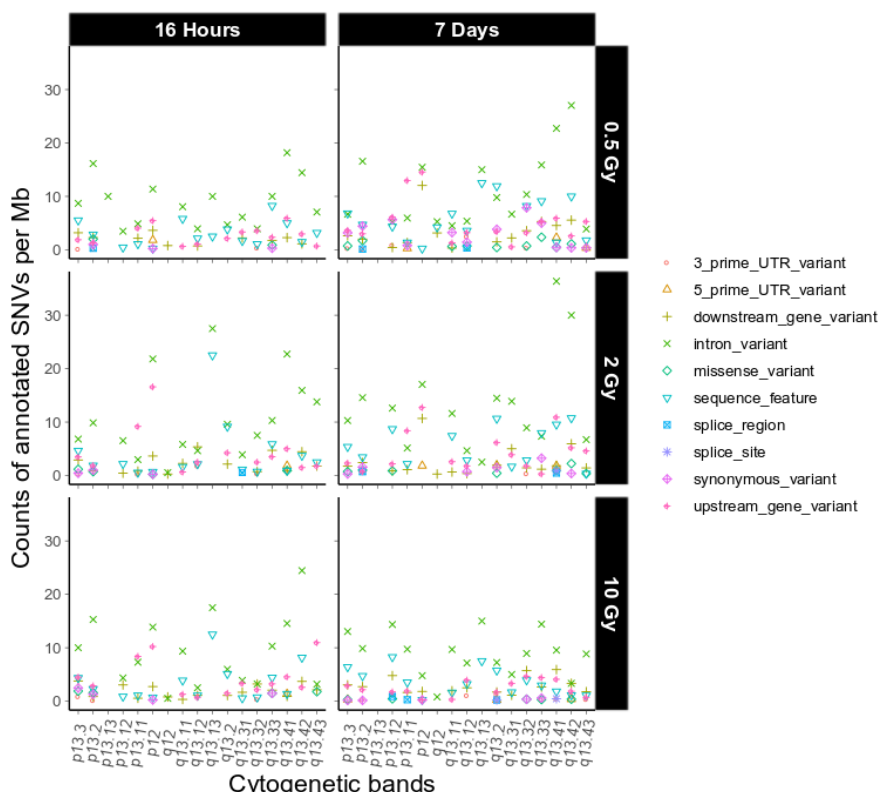
Figure A6. Sequence ontological information for the IR-induced variants observed on chromosome 19 over cytogenetic band, filtered for refseq IDs for dataset 2. For further explanation of the used combination of sequence ontology terms see Table 4. Int. J. Mol. Sci. 2019 , 20 , x FOR PEER REVIEW